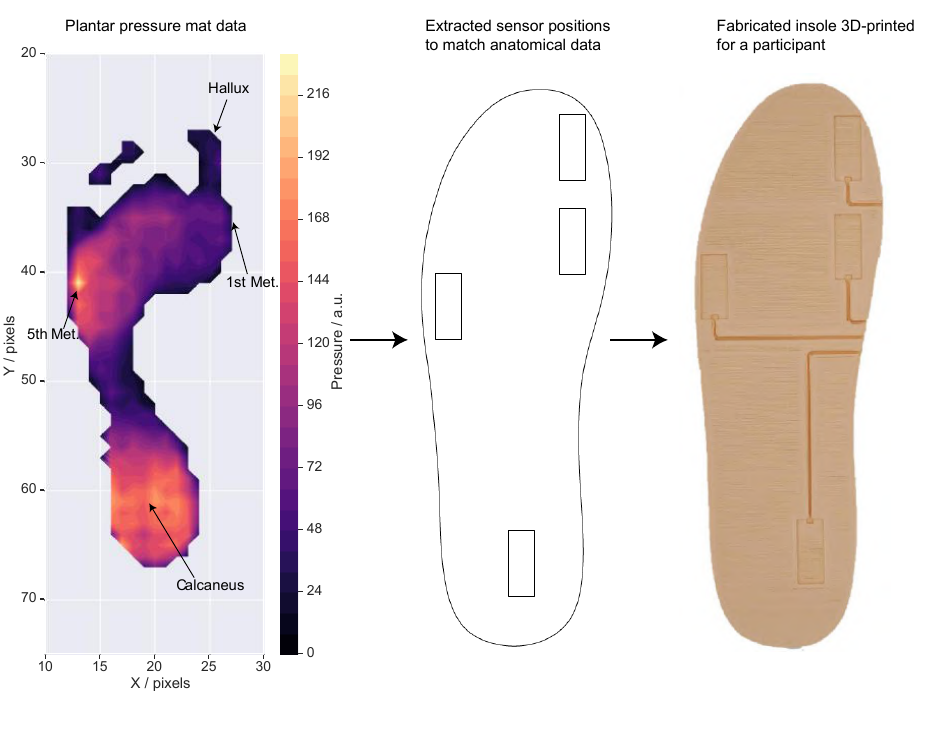
Figure 4. The process to generate a personalised insole for a participant, showing the steps to convert the plantar pressure mat data into a 3D-printed insole.